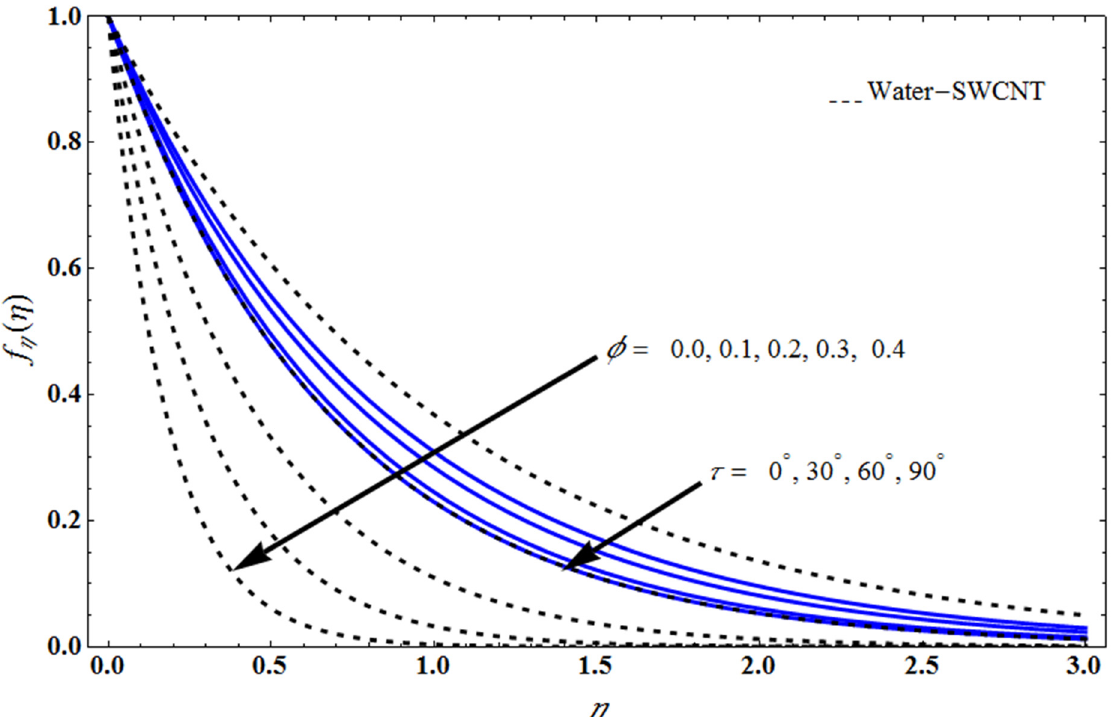
( ) η η f on for several values of η